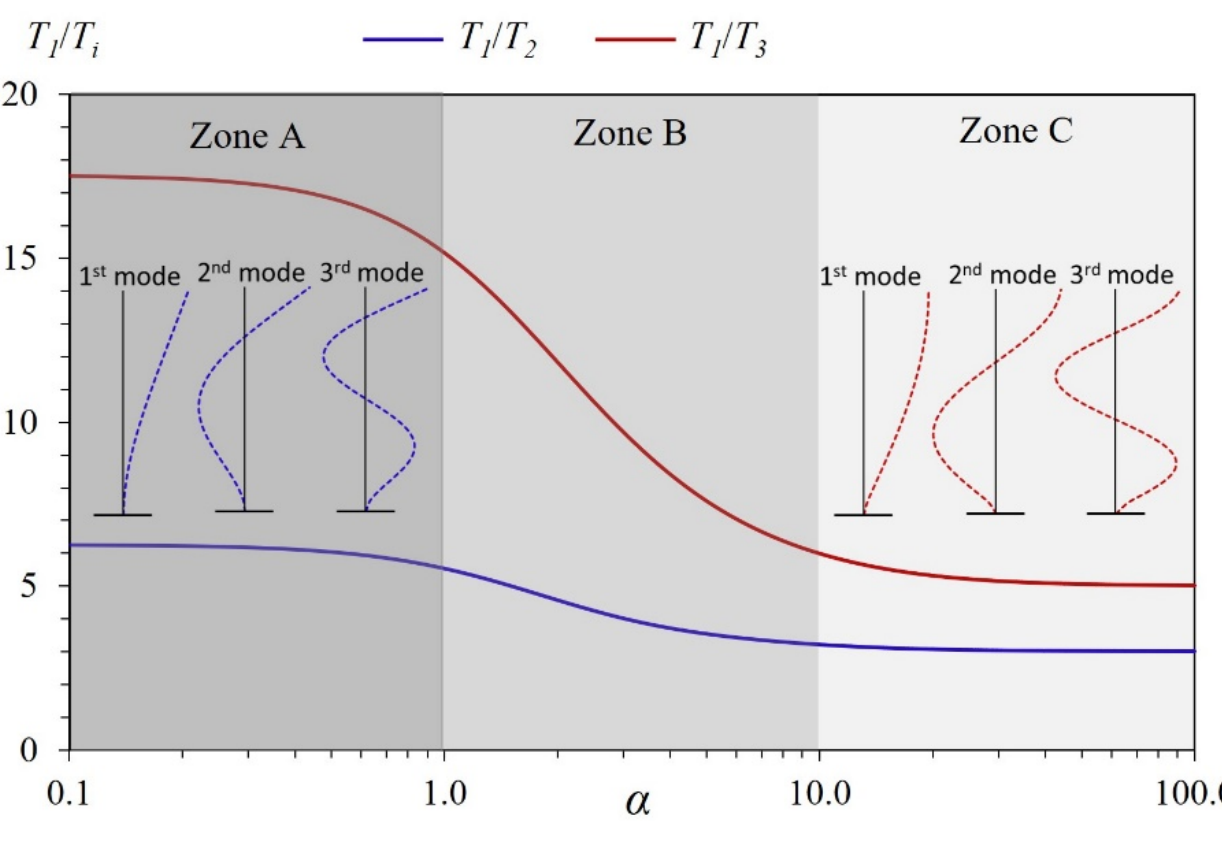
Figure 2. Effect of α on the period ratios of CSFCBM.